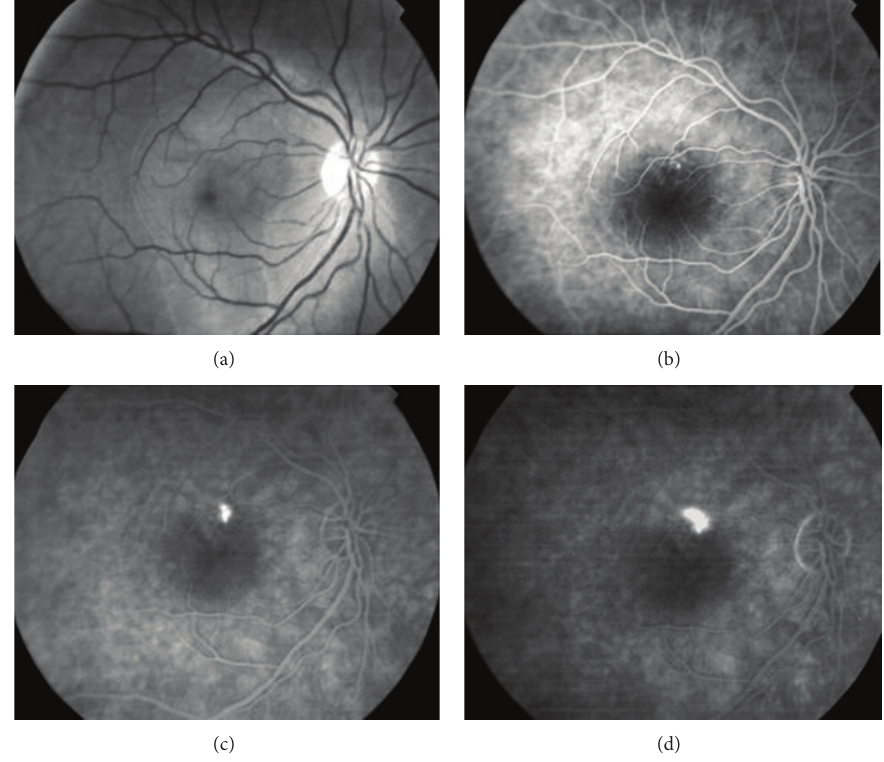
Figure 1: (a) Red-free photograph shows the right eye before thermal laser therapy with a large macular serous retinal detachment measuring about 4 disc diameters. (b) Early fluorescein angiography (FA) phase shows a small pinpoint area of retinal pigment epithelium (RPE) leak superonasal to the fovea. (c) Midphase fluorescein angiography (FA) shows an increase in the small focal area of RPE leak superonasal to the fovea. (d) Late phase FA shows an increase in the superonasal focal hyperfluorescence with an inkblot-like leakage pattern.